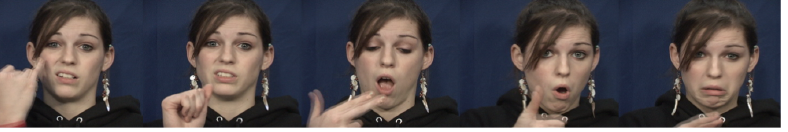
Figure 2. Samples of a video sequence of a native ASL signer signing ‘‘If # Sarah have a party tomorrow’’.